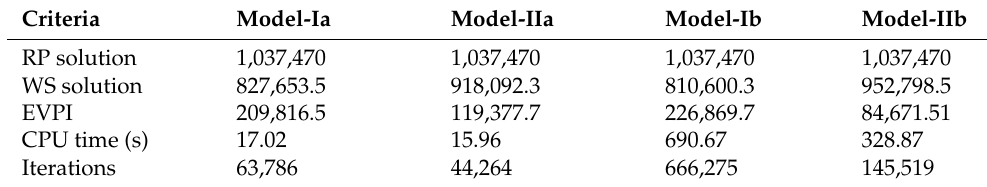
Table 5. Comparison of the results of the models developed.